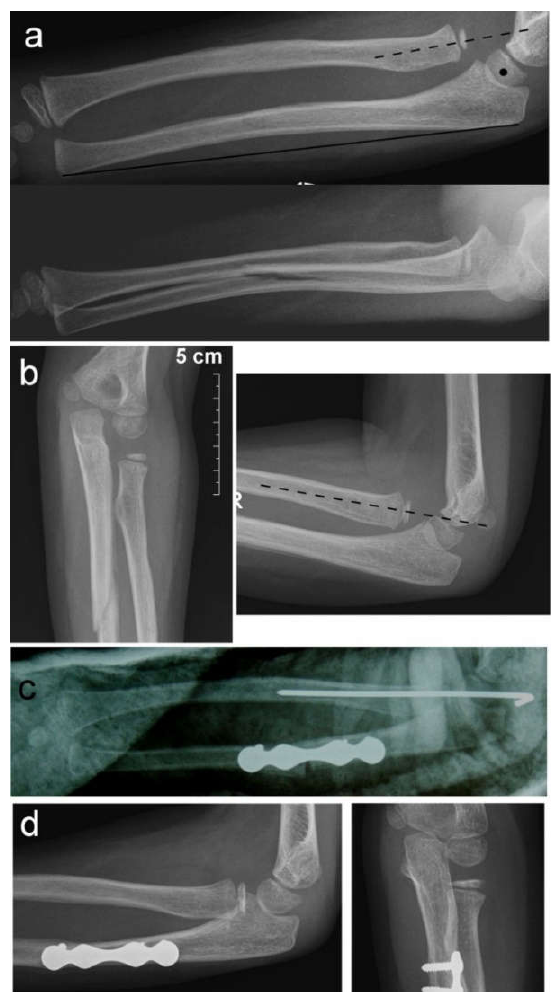
Figure 1. Neglected Monteggia fracture: ( a ) anterior dislocation of the radial head with heterotopic ossification visible on a lateral view; ( b ) AP view; ( c ) high posterior angulation and elongation os- teotomy of the ulna stabilized with a plate and four screws. Transcapitellar fixation of the radial head with Kirschner wire; ( d ) the reduced radial head and healed ulnar osteotomy are visible on a lateral X-ray before removal of the plate and screws.